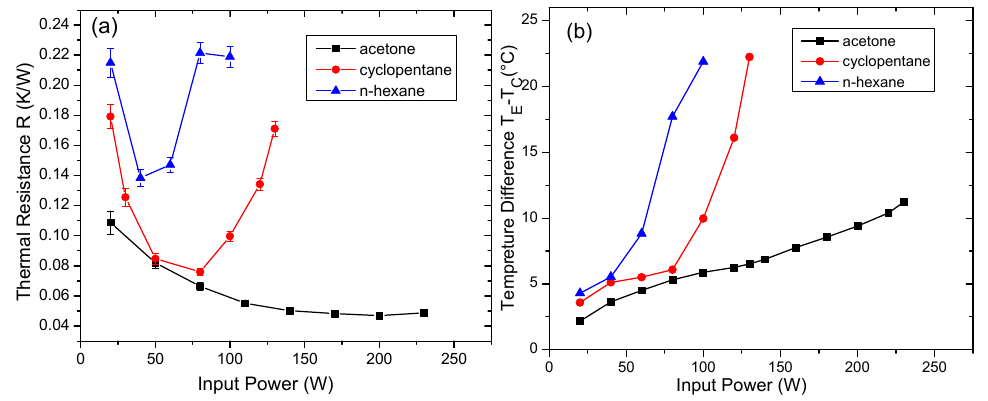
Figure 9. Effect of working fluid on ( a ) thermal resistance, and ( b ) temperature difference of the MF-AHPA at a 45° inclination angle. MF-AHPA at a 45 ◦ inclination